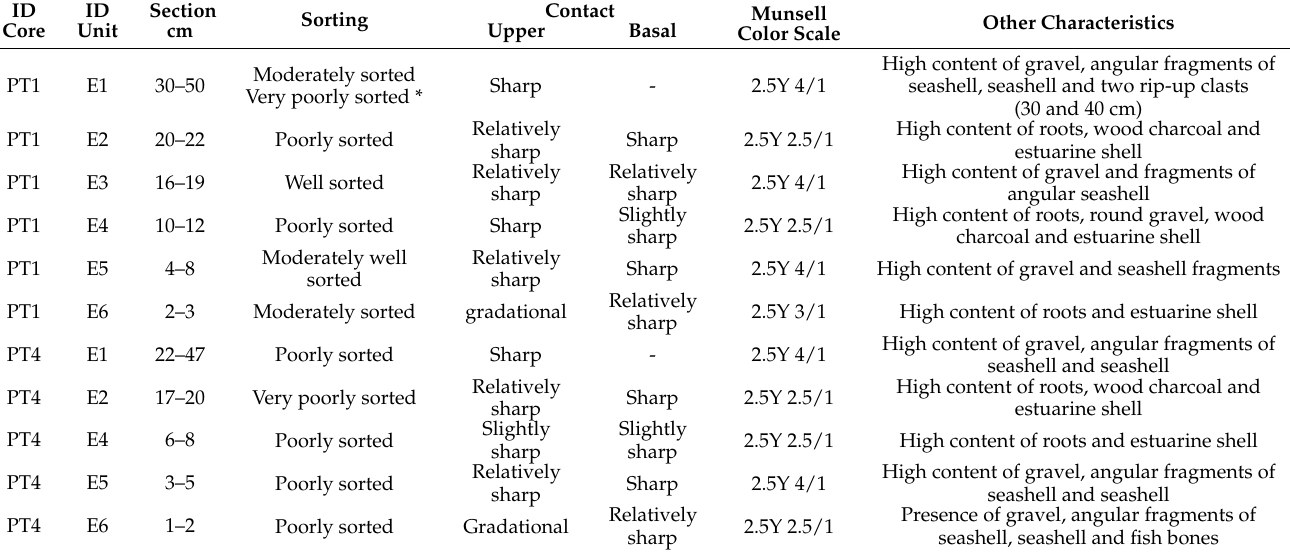
Figure 4. Sedimentological features of PT1 ( A ) and PT4 ( B ) cores; in gray, the deposits associated with thick granulometry; in brown, the fine grain size, related with marine and continental deposits. Each marine or fluvial deposit is highlighted with numbers 1, 3 and 5 and 2, 4 and 6, respectively. Table 3. Sedimentological characteristics of meteorological event deposits along the PT1 and PT4